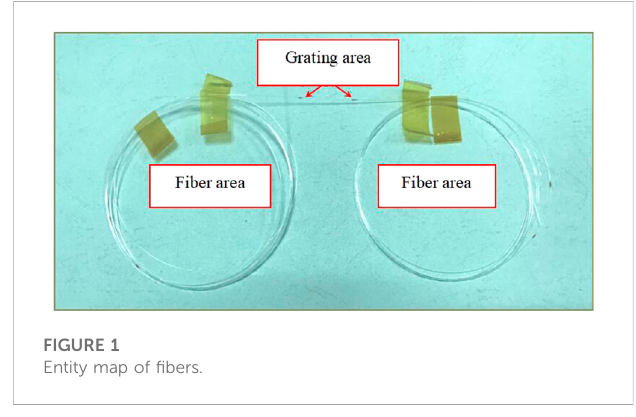
FIGURE 1 Entity map of fi bers.